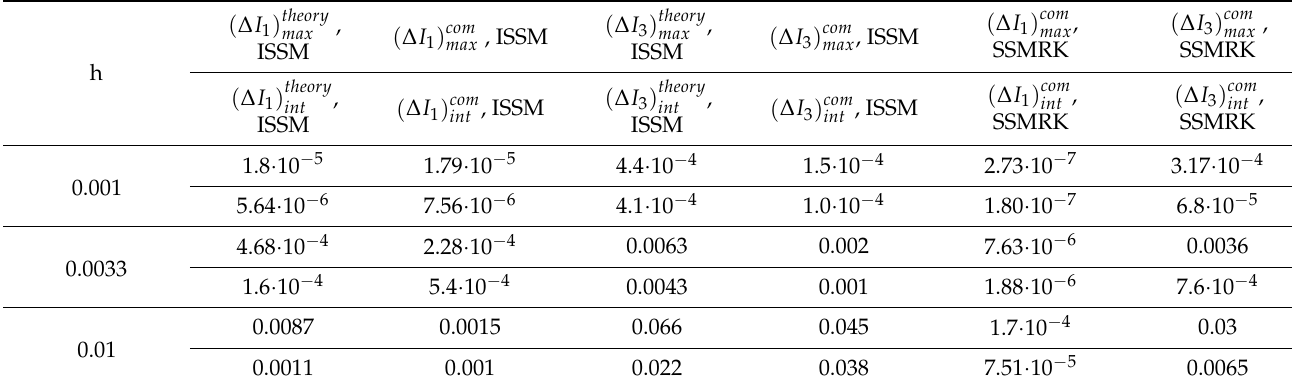
Table 3. Influence of the spatial step on the energy invariant deviation and the Hamiltonian deviation when using the ISSM and the SSMRK for computation. The upper row corresponds to the local invariant deviation, the low row–to the integral deviation of the